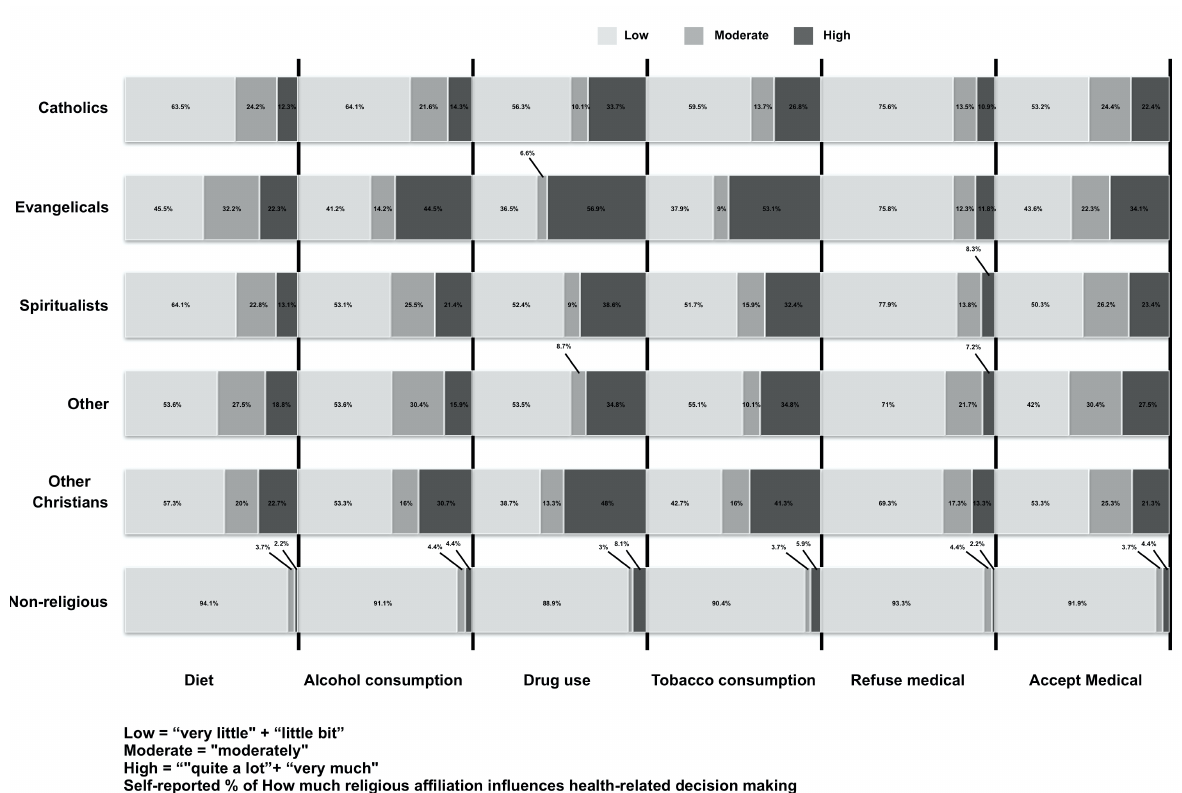
Figure 2. Religious affiliation’s influences in health-related